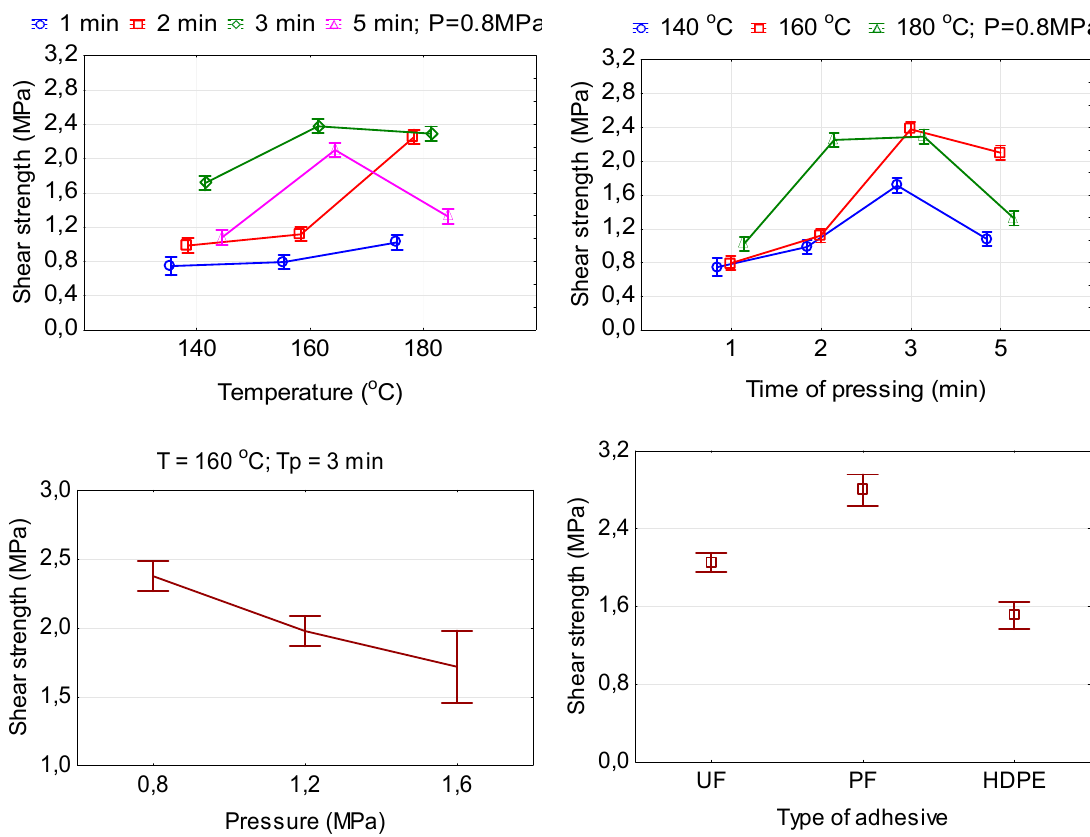
Figure 3. The relationship between the shear strength of plywood and hot-pressing parameters.